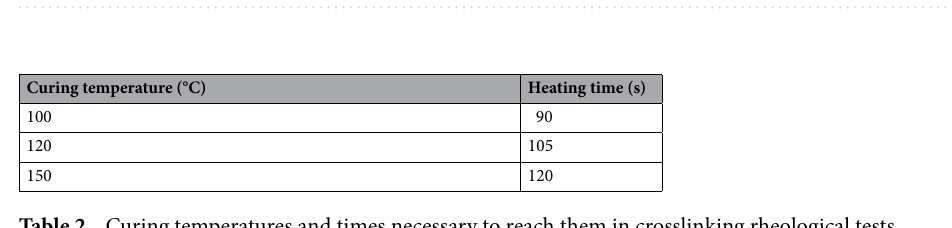
Table 1. Curing parameters.